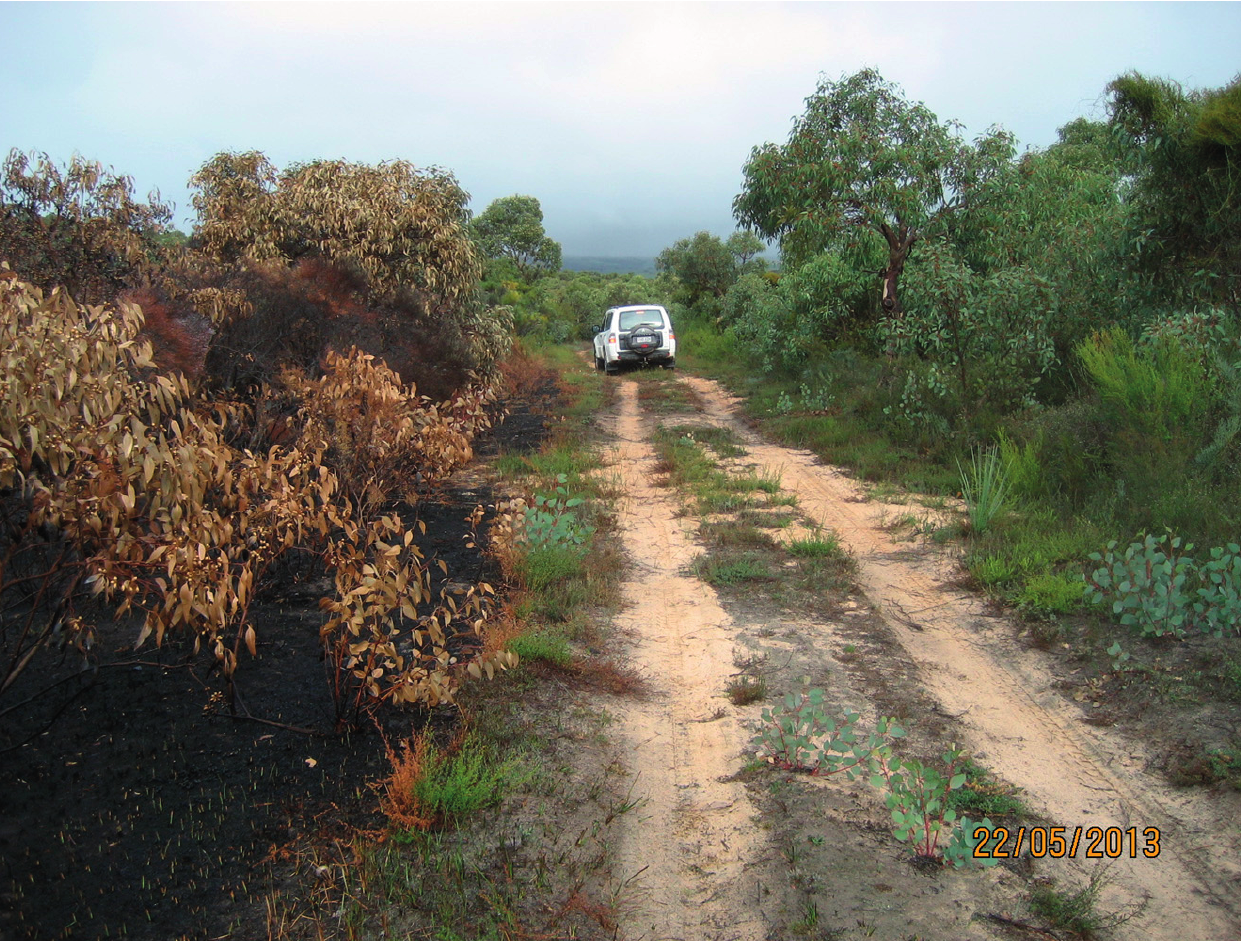
Figure 9. Southern brown bandicoot habitat. Cox Scrub Conservation Reserve, Fleurieu Peninsula (Photo: A. Malcolm